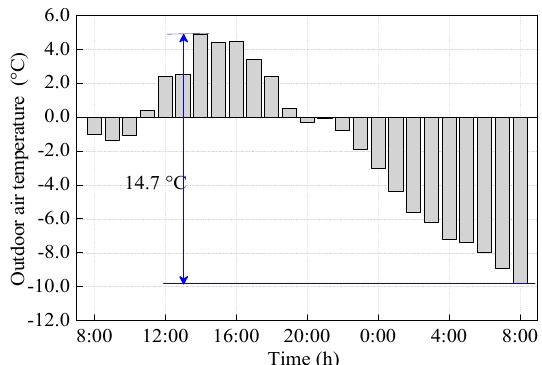
Figure 3. Solar radiation intensity.